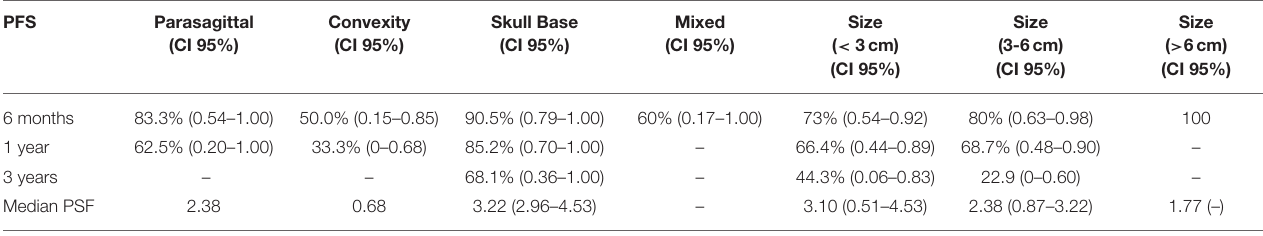
TABLE 3.2 | Median progression free survival and progression free survival at 6 months, 1 year, and 3 years based on tumor location and size ( n = 43). PFS